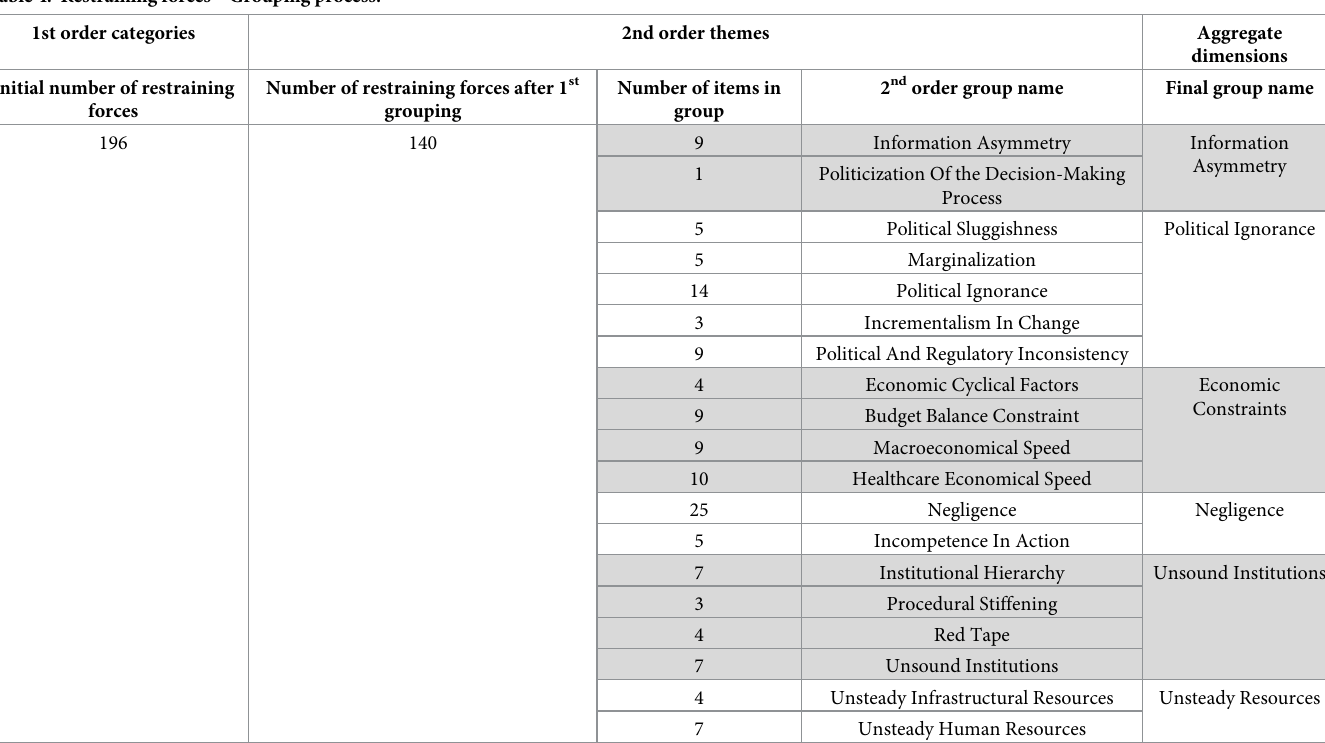
Table 4. Restraining forces—Grouping